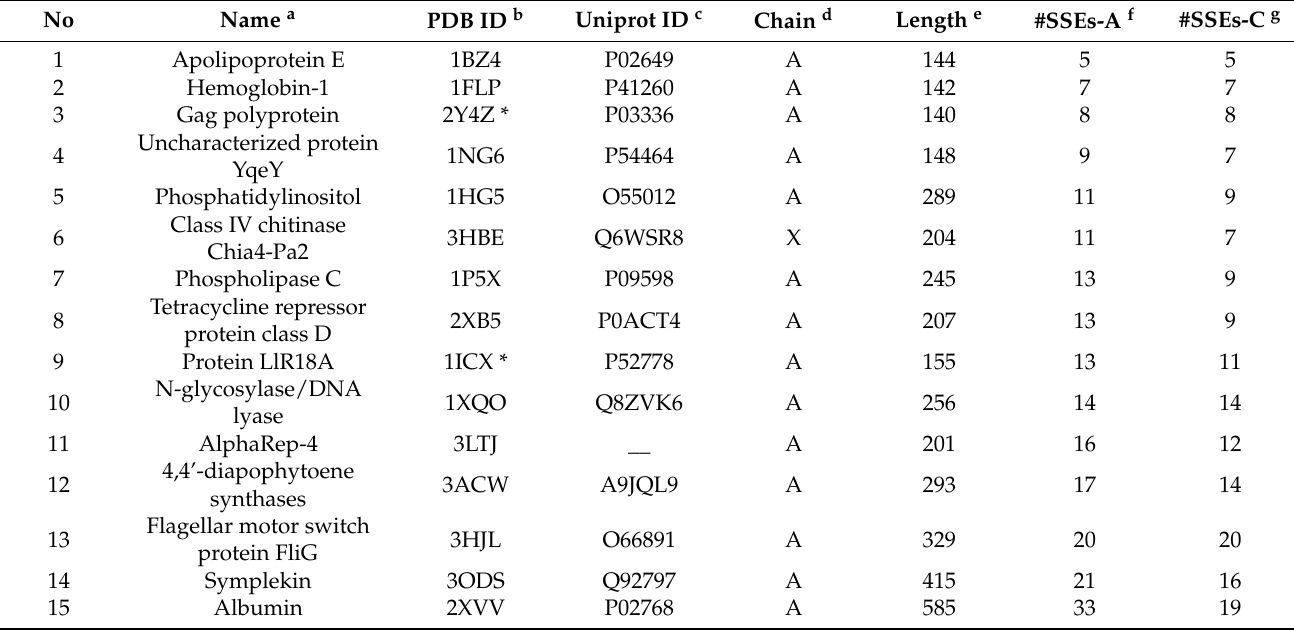
Table 2. The information of the simulated cryo-EM